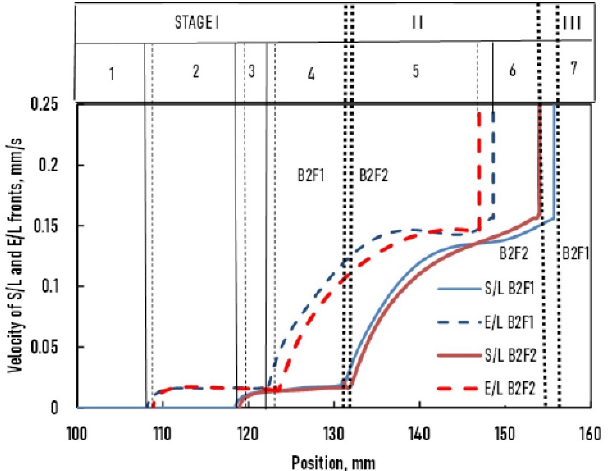
Figure 3. Velocity of S/L and E/L fronts vs. position of B2F1 and B2F2 samples. The thin vertical solid and broken lines mark the margin of the relevant parts of the sample, while the dotted vertical lines show the instances where the solidification conditions were changed from stage I to stage II.